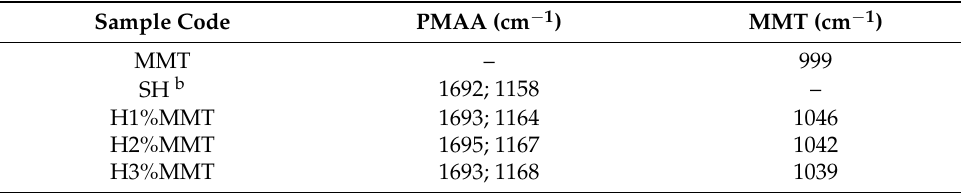
Figure 5. FT-IR spectra of the composite xerogels investigated and MMT. SH: 10%MAA, 2 mol%BIS based on MAA, 0%MMT. Table 4. Characteristic FT-IR peak values of the investigated samples a